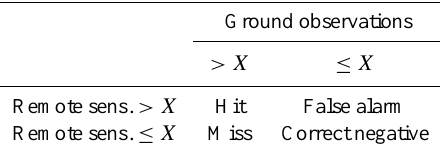
Table 3. Contingency table to measure the correspondence between rain gauge data (column headers) and remotely sensed estimates (row headers) with respect to a threshold intensity X (mmday − 1 ). A value of 1 is added to the appropriate field for every analysed